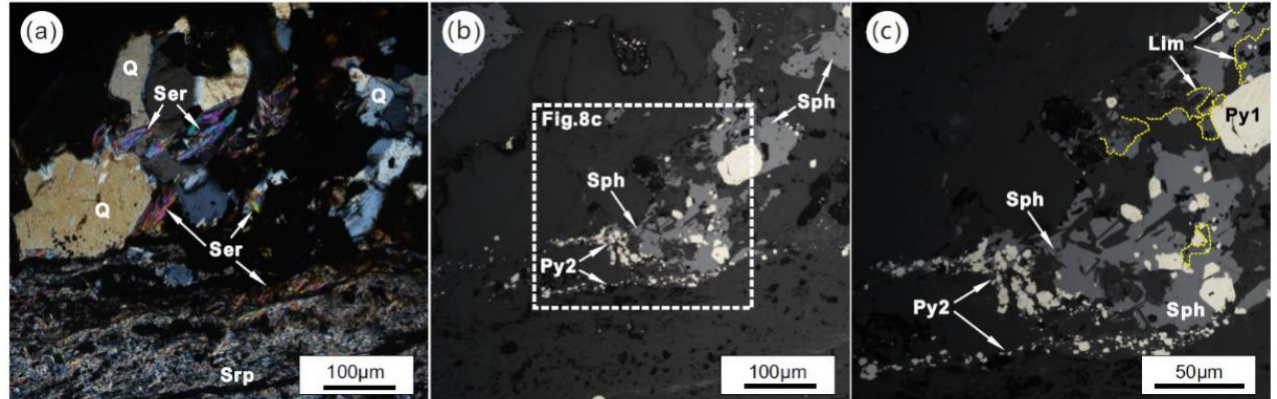
Figure 8. Paragenetic relationship between sphalerite and sericite at the Liushuping Au–Zn deposit. ( a ) coexistence of sericite, quartz, and serpentine in stage 2, under orthogonal polarization; ( b ) coexistence of sericite, sphalerite, and fine-grained pyrite (Py2) to replace coarse-grained pyrites (Py1), the same position as photo ( a ); ( c ) coexistence of sericite and sphalerite, partial enlargement of ( b ). Abbreviations: Lim—limonite; Py—pyrite; Q—quartz; Ser—sericite; Srp—Serpentine; Sph—sphalerite.